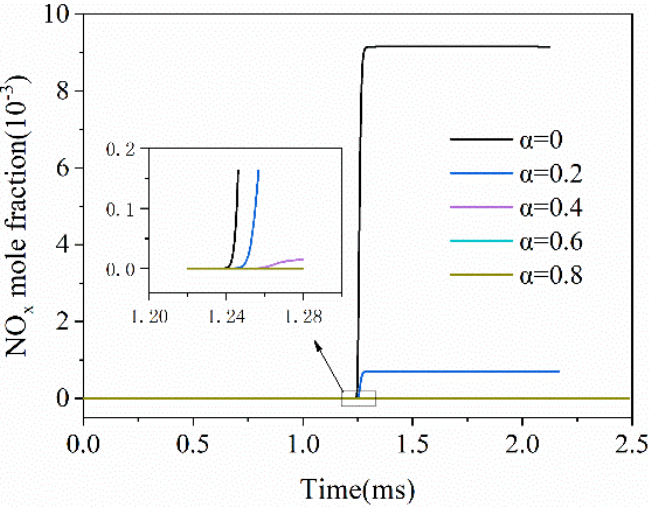
Figure 13. Variation curves of NO x mole fraction under different α .